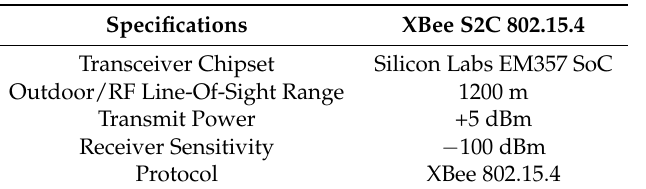
Figure 12. XBee (Digi International, Minnetonka, MN, USA) wireless transmission module. Table 4. The specifications of a XBee S2C.